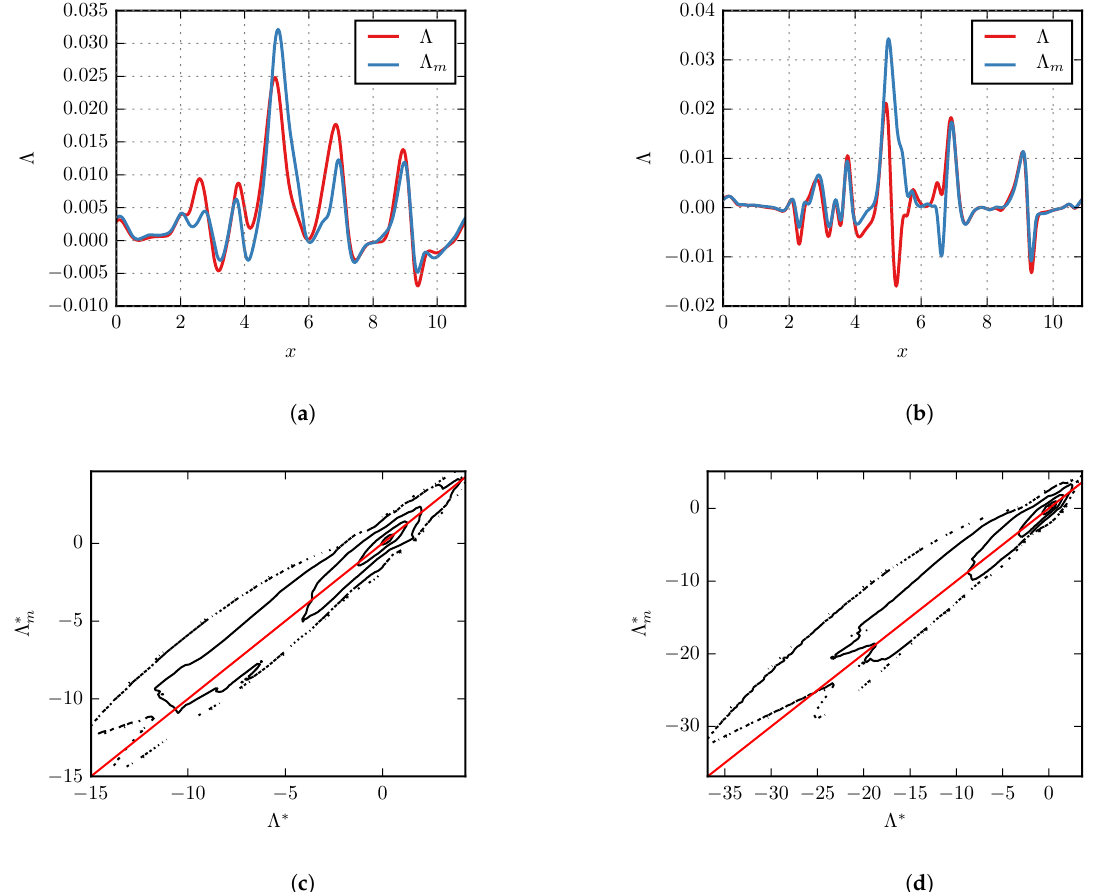
Figure 6. Same as in Figure 5 but using the Gaussian filter. The correlation coefficients are R c = 0.97 at filter scale k (cid:96) = 8 and R c = 0.97 at k (cid:96) = 16. All four panels indicate excellent correlation between Λ and Λ m.